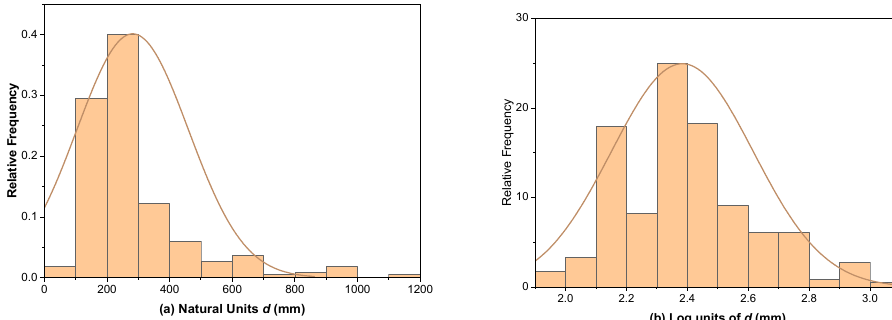
Figure 3. Histogram of beam effective depths: ( a ) before log transformation; ( b ) after log transfor- mation.